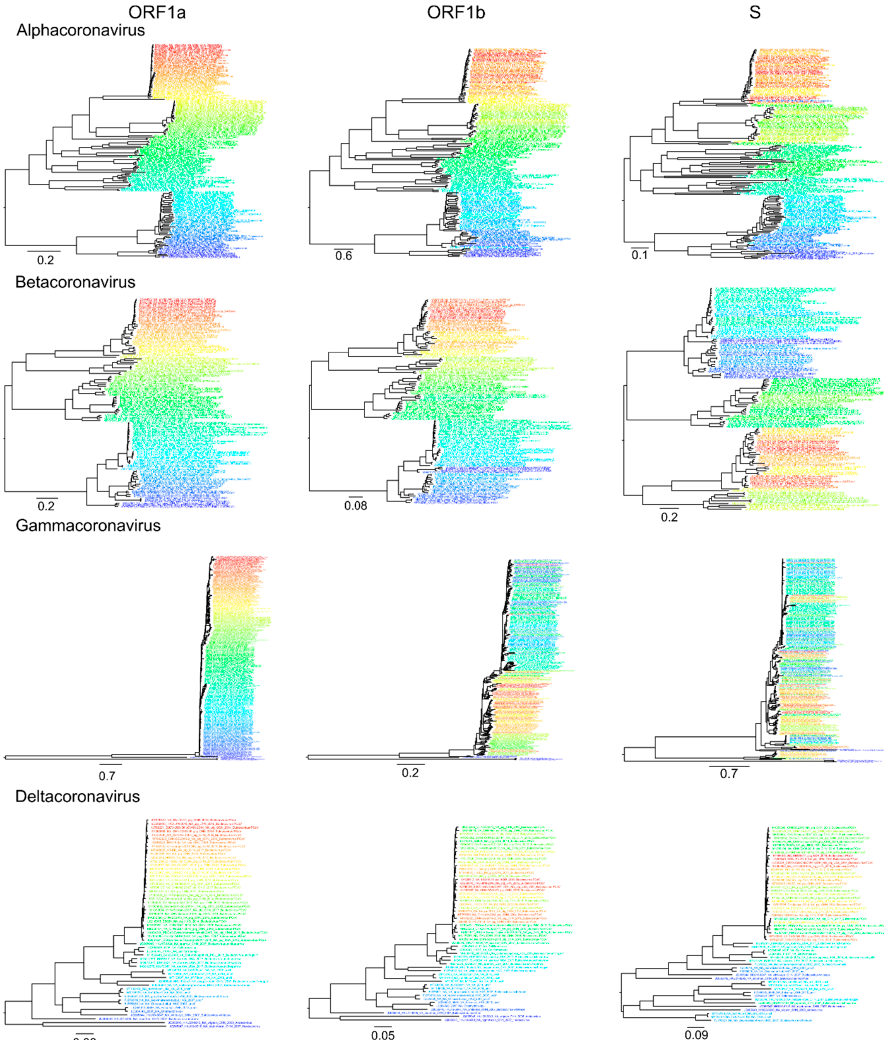
Figure 4. Taxon mixing in maximum-likelihood phylogenies of ORF1a , ORF1b, and S genes for four coronavirus genera. The colors of taxa names match in trees for each genus. Recombination within the S gene was limited in all four species, but variations re-